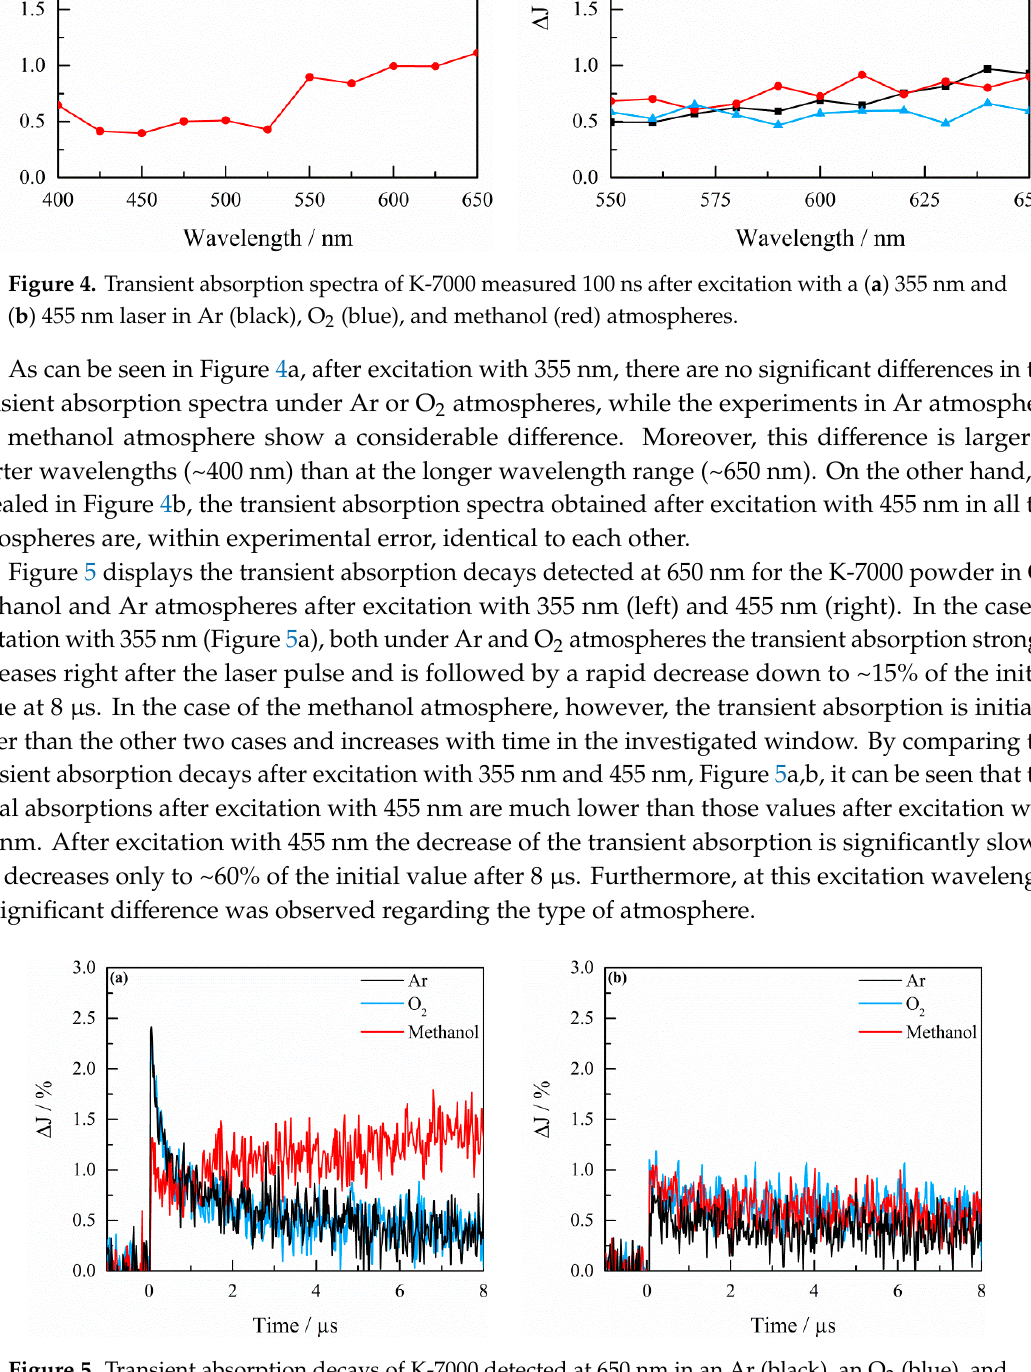
Figure 5. Transient absorption decays of K-7000 detected at 650 nm in an Ar (black), an O 2 (blue), and a methanol (red) atmosphere, after excitation with ( a ) 355 nm and ( b ) 455